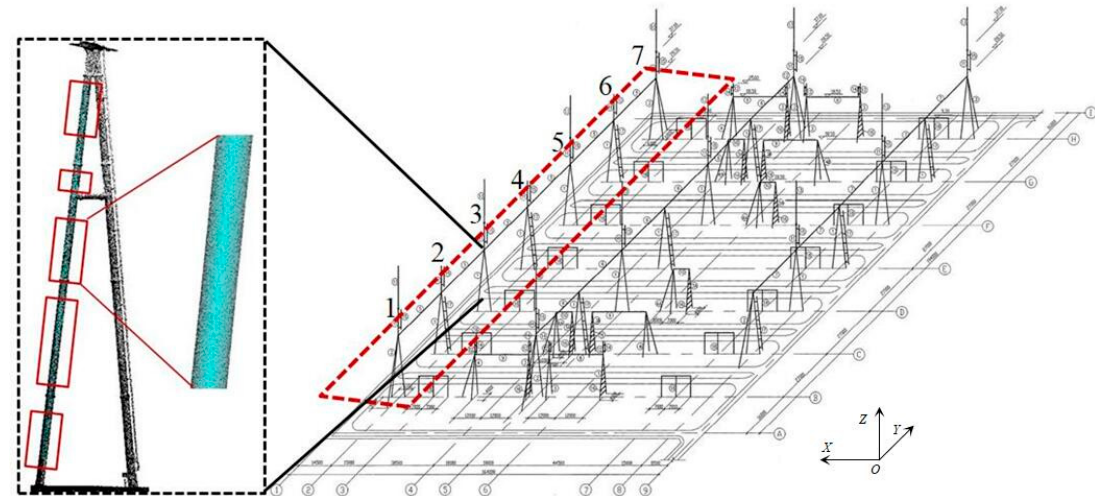
Figure 7. Piecewise fitting. Numbers 1–7 in figure indicate the column number.